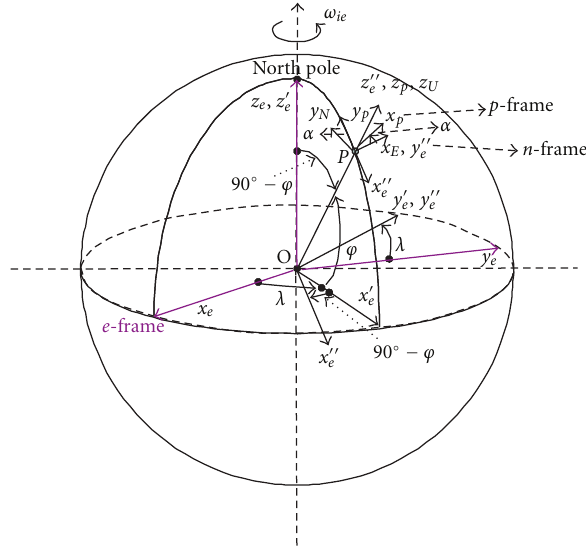
Figure 5: The relation between e -frame and p -frame.